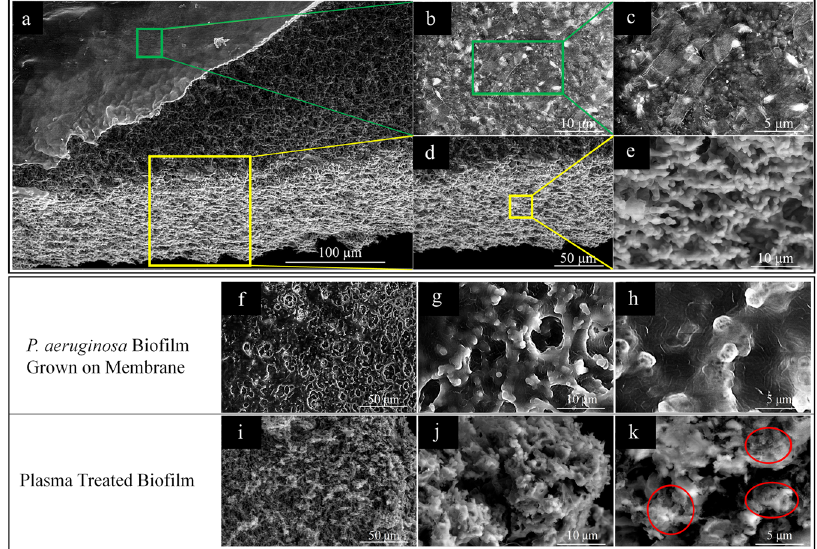
Fig. 5 SEM of P. aeruginosa bio fi lm grown on the eardrum-mimicking membrane. a P. aeruginosa bio fi lm on the top side (top left corner, green box) and the cellulose nitrate membrane on the bottom side (lower center, yellow box). Scale bar represents 100 µm. b , c Magni fi ed images of the green box in a . d , e Magni fi ed images of the yellow box in a . f – h P. aeruginosa bio fi lm formed on the cellulose nitrate membrane. i – k P. aeruginosa bio fi lm on the membrane after 20 min of the microplasma black dashed line represents the antibiotic susceptibility response the MIC 50 value for the bio fi lm decreased by ~3 orders of of the control group (i.e., no treatment). Compared with the MIC 50 magnitude (1.62 × 10 − 4 dilution) after 20 min of treatment, when value for the planktonic cells, the corresponding value for the compared to the bio fi lm control (Fig. 6b). These results suggest bio fi lms was found to be a factor of ~1.44 larger (1.33 × 10 − 1 that microplasma treatment signi fi cantly reduces the viability of dilution), which is expected as the bio fi lm acts as a shelter for the both P. aeruginosa planktonic cells and bio fi lms, thereby leading bacteria from external conditions and pressures 35 . Nonetheless, to a signi fi cant synergistic effect with antibiotics.